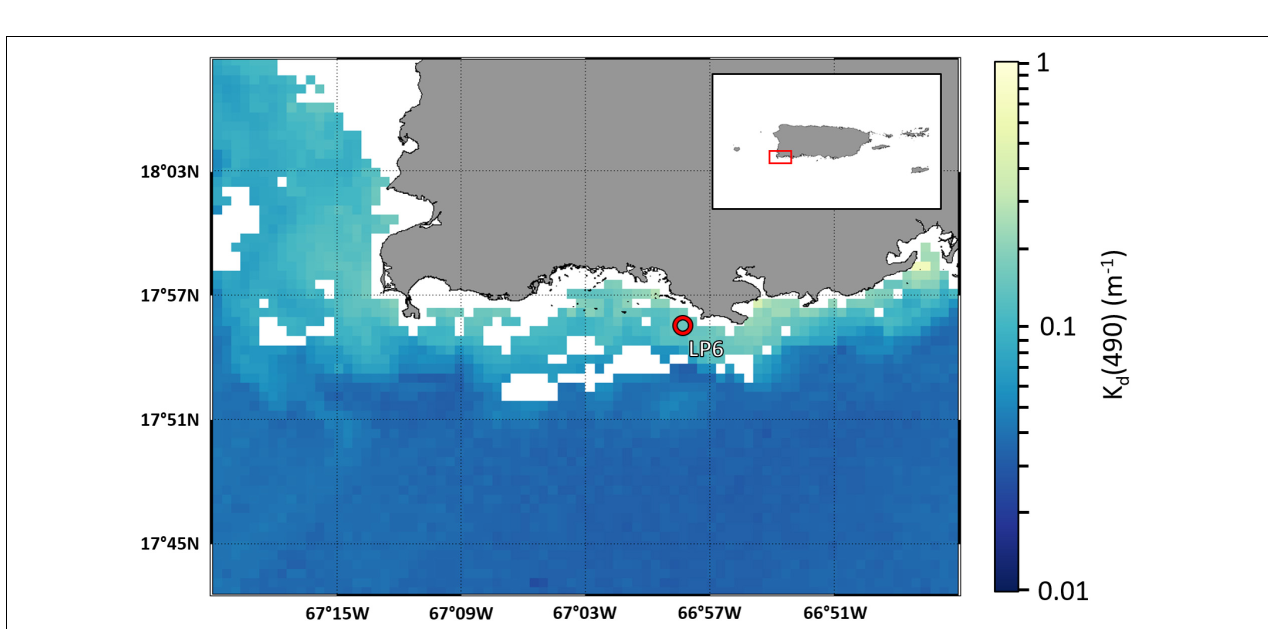
FIGURE 2 | Maps of VIIRS K d (490) for West Maui, HI for (A) November 27, 2018 (750 m pixel resolution). White areas are missing data due to cloud cover or flagged due to poor quality. The red circles show the locations where 11 in situ optical data measurements were taken on November 26 or November 28, 2018 using a Sea-Bird Scientific HyperPro II; and (B) the 7-days period from November 24–30, 2018, illustrating the variability in satellite data coverage. Sites marked with a white asterisk were considered optically shallow during the time of measurement (see Supplementary Table 1 ).